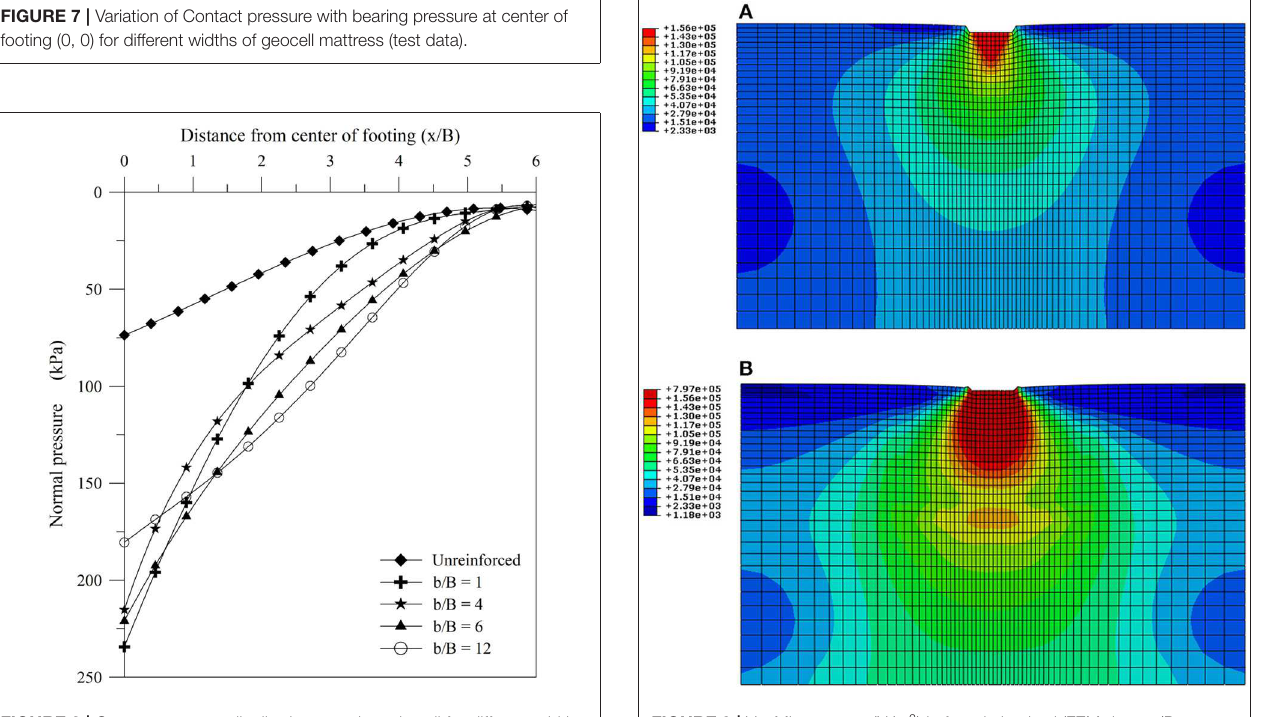
FIGURE 9 | VonMises stress (N/m 2 ) in foundation bed (FEM data, s/B = 20%). (A) Unreinforced. (B) Geocell